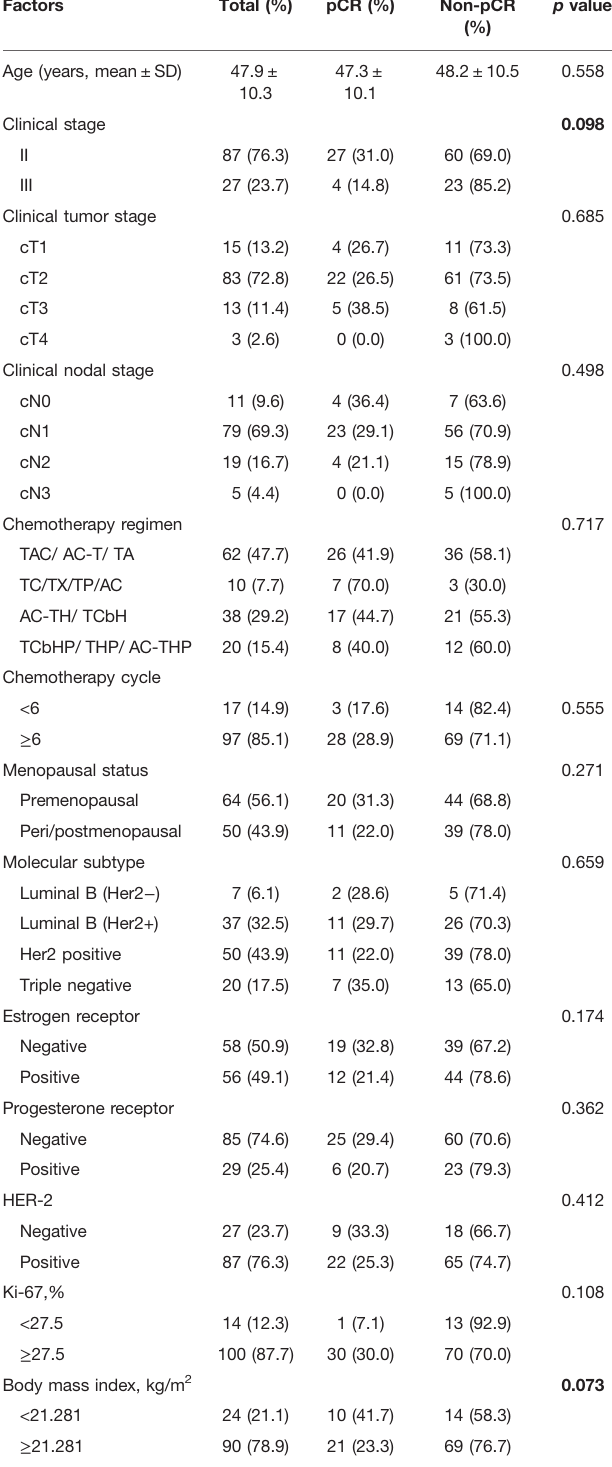
TABLE 1 | Clinical characteristics of 114 patients with breast cancer and their correlation with the pathologic complete response rate after neoadjuvant